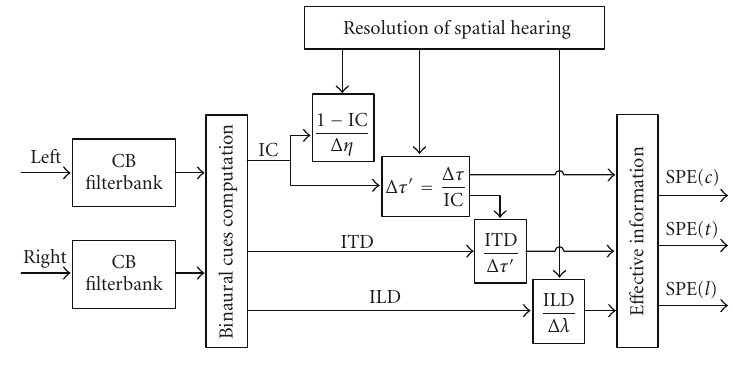
Figure 12: SPE calculation.